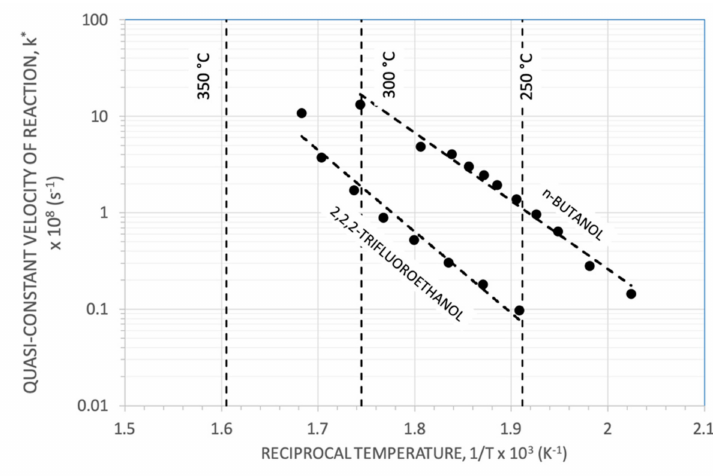
Figure 13. Quasi-constant of the velocity reaction k ∗ as a function of the reciprocal of the stress temperature for n-butanol, and